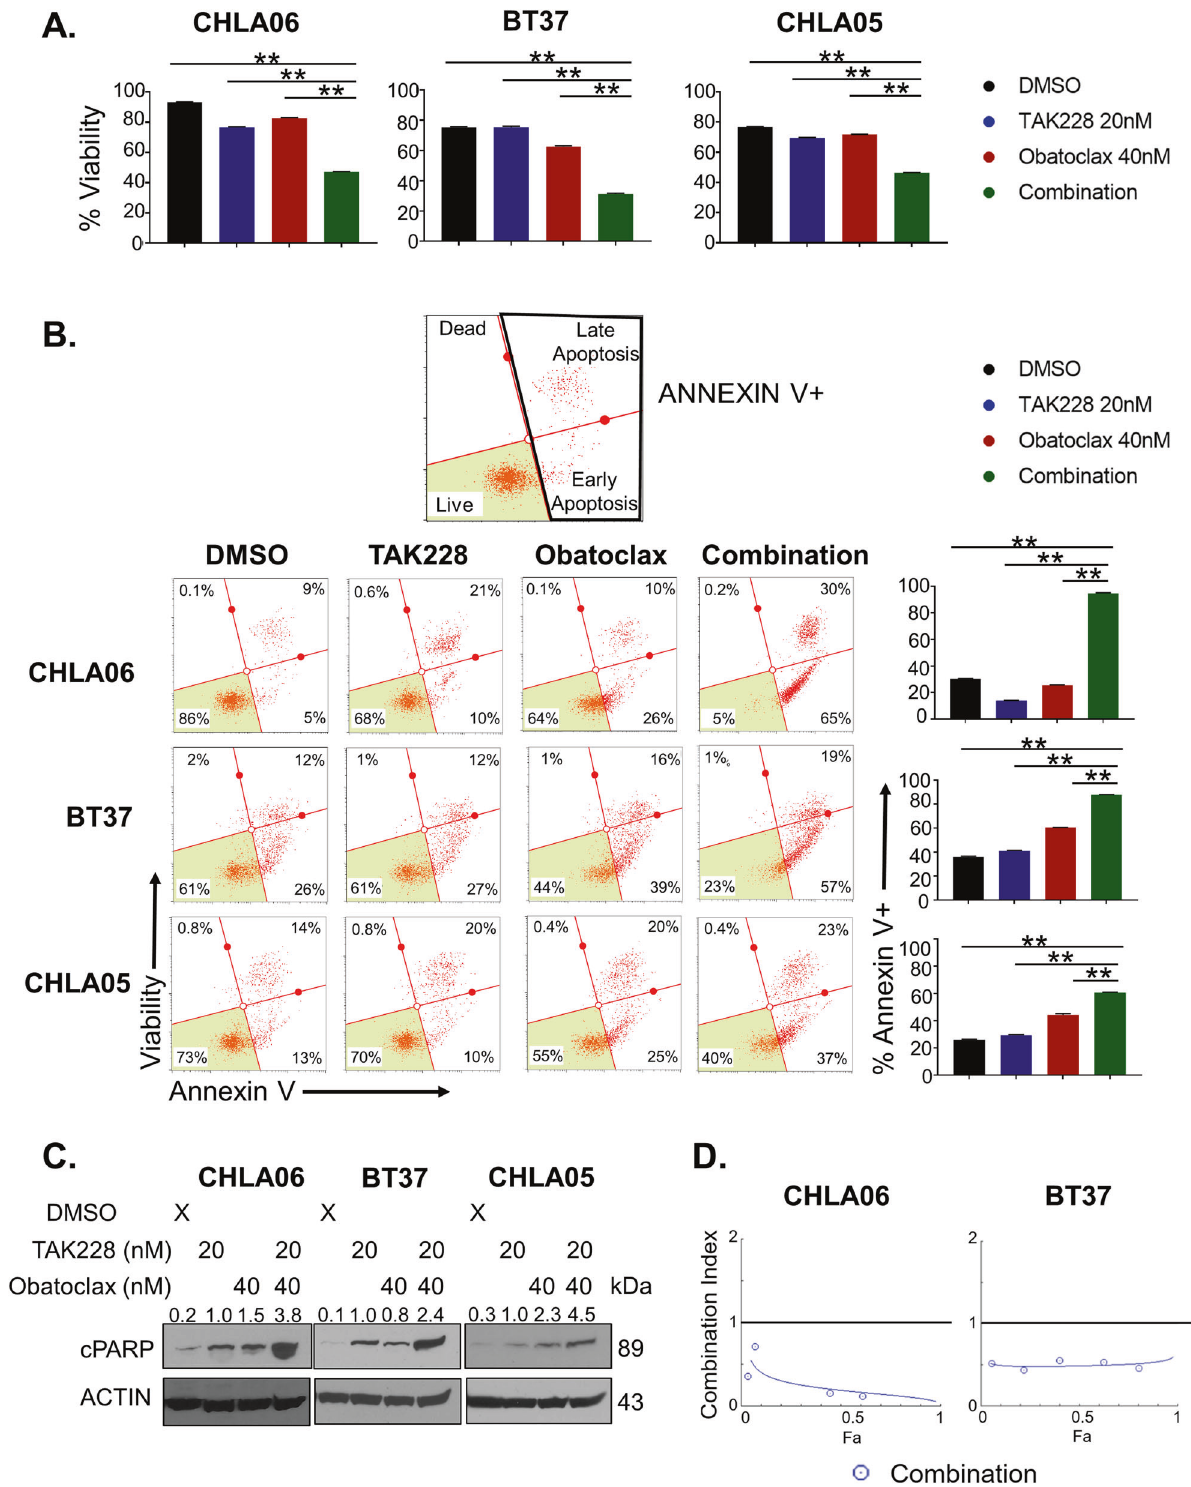
Fig. 4 TAK-228 combines synergistically with Obatoclax to induce apoptosis and cell death in AT/RT. A Percent viability as determined by MUSE cell viability assay 72 h after TAK-228 20 nM combined with Obatoclax 40 nM compared with each medication alone and DMSO control. The results are presented as the mean + / − SEM, * p < 0.05 ** p < 0.005, ANOVA. B Percent of cells undergoing apoptosis as determined by the ANNEXIN-V MUSE assay 24 h after treatment. Right side of the graph represents Annexin-V + cells, right lower-quadrant early apoptotic cells, upper-right quadrant late apoptotic cells. Graphs represent percent of cells Annexin-V positive. The results are presented as the mean + / − SEM, ** p < 0.005, ANOVA. C Western blot for cleaved PARP expression 24 h after treatment. Numbers above blots represent quanti fi cation of protein expression normalized to ACTIN. D Formal synergy testing of fi xed dose ratios of TAK-228 and Obatoclax by the CompuSyn Method of Synergy. Combination index <1 (below horizontal line on the graph) represents synergistic combinations.